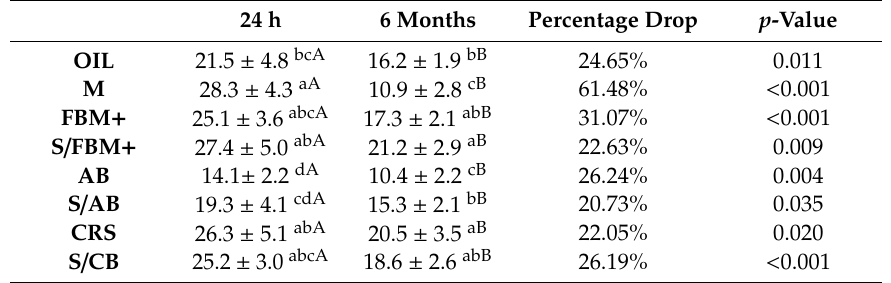
Means with same superscript lowercase letters within each column and same superscript uppercase letters within each row are not statistically significant at p =